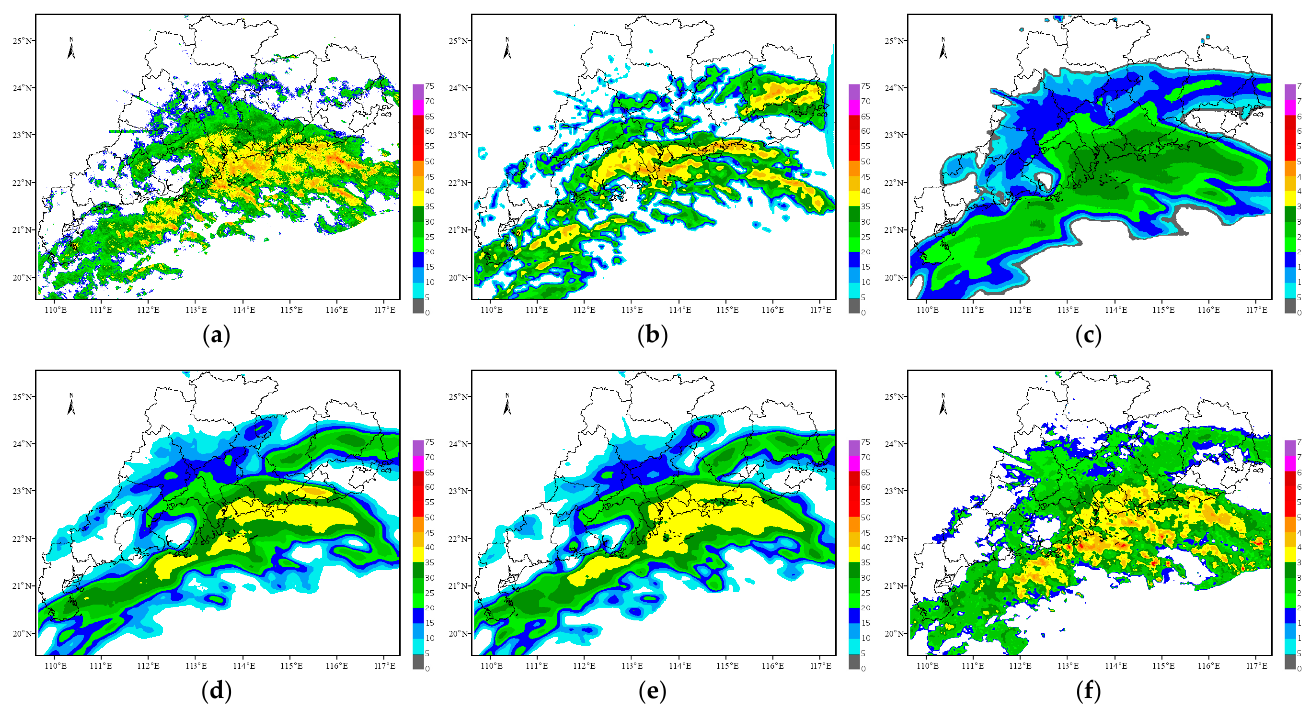
Figure 12. Nowcasting results of the typhoon process for the next 1.5 h. (a) Observation; (b) Opti- calflow; (c) ConvGRU; (d) PredRNN; (e) PredRNN V2; (f) TSGAN.